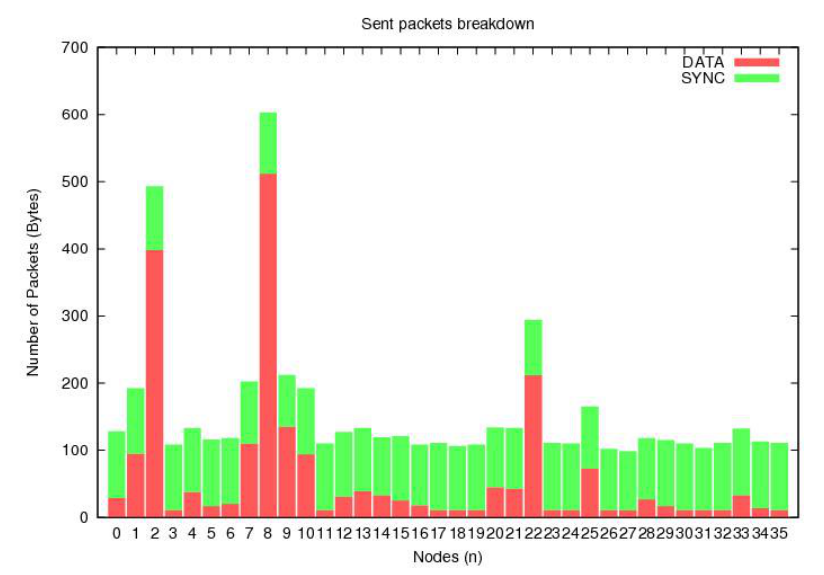
Figure 5. The number of packets as a function of total number of IoT nodes in the